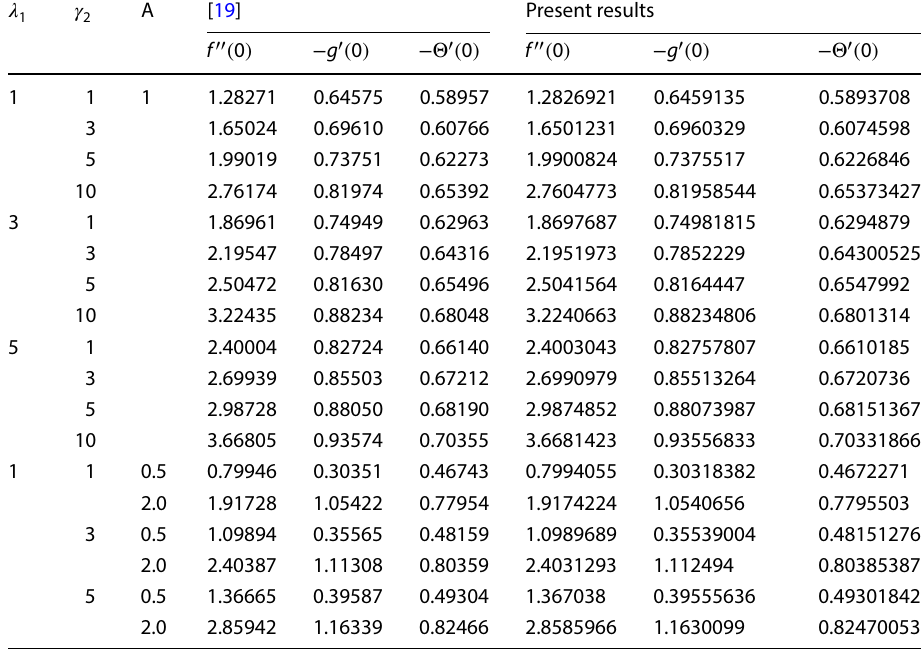
Table 1 The skin friction coefficients, heat and mass transfer rate comparison when M = E = 𝛿 = 𝛾 Rd = 1 = Θ t = Le = Bi = Ec = Nb = Nt = 0 , Pr = 0.7